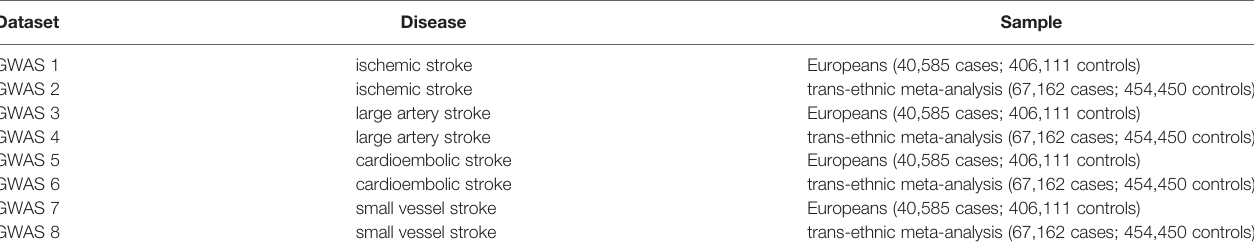
TABLE 1 | GWAS data description. Dataset